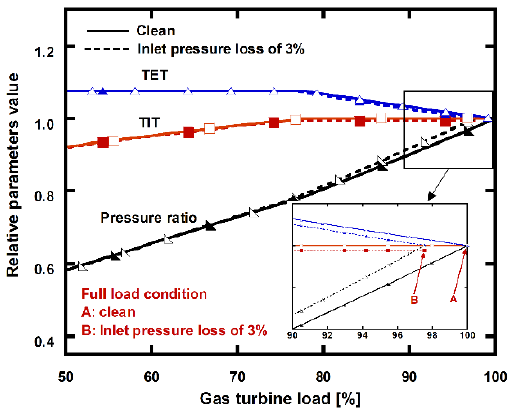
Figure 11. Partial load parameter variations in the schedule-based control: impact of the compressor inlet pressure loss.